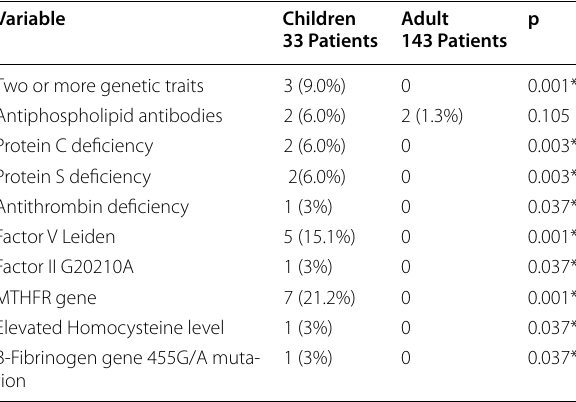
By Chi square test and Fisher exact test, *p value was